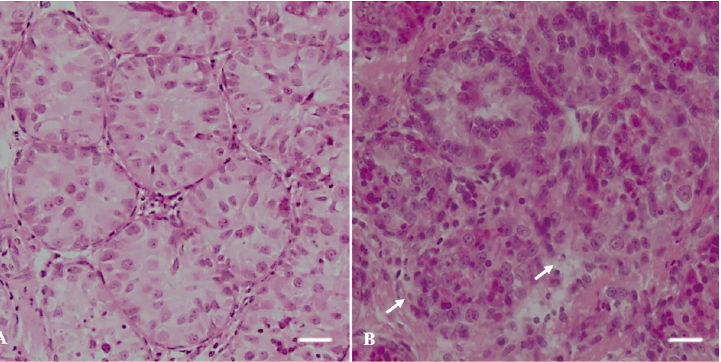
Fig 2. Histological evaluation of seminiferous tubules in testicular tissue from prepubertal cats. (A) seminiferous tubules with intact morphology (Score 1; HE), (B) seminiferous tubules with degenerated morphology (Score 0; HE). White arrows indicate degenerated seminiferous tubule. Bar = 5 μ